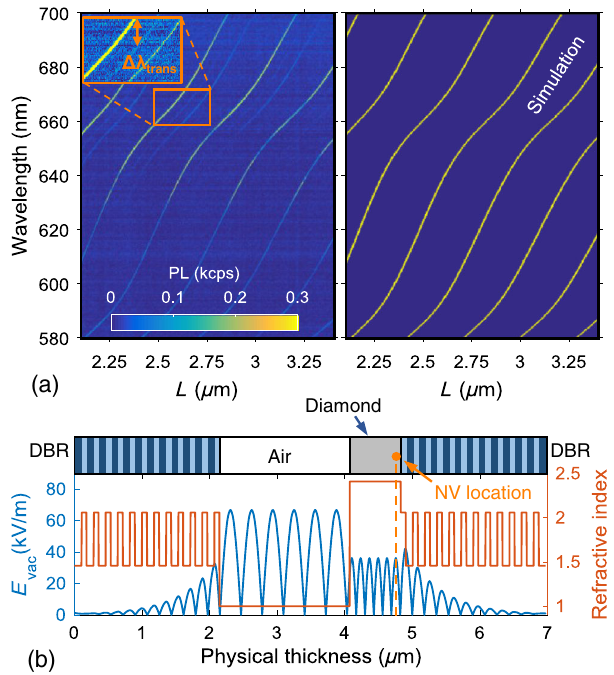
FIG. 4. (a) Left panel: Measured PL spectra on tuning the microcavity length L over a wide range. The inset highlights the higher-order lateral modes. Right panel: Calculated mode dispersion. (b) The layer structure of the microcavity along with the refractive index dependence on z . The vacuum electric field E is plotted against z for ð x; y Þ ¼ ð 0 ; 0 Þ for the lowest vac attainable fundamental microcavity mode. Parameters: Diamond ¼ 0 . 77 μ m, air-gap thickness L ¼ 1 . 96 μ m, dia- thickness t d ¼ 2 . 41 , refractive indices of Bragg mond refractive index n d Þ ¼ ð 2 . 06 ; 1 . 46 Þ , and radius of curvature of top ; n mirror ð n H L mirror R ¼ 16 μ